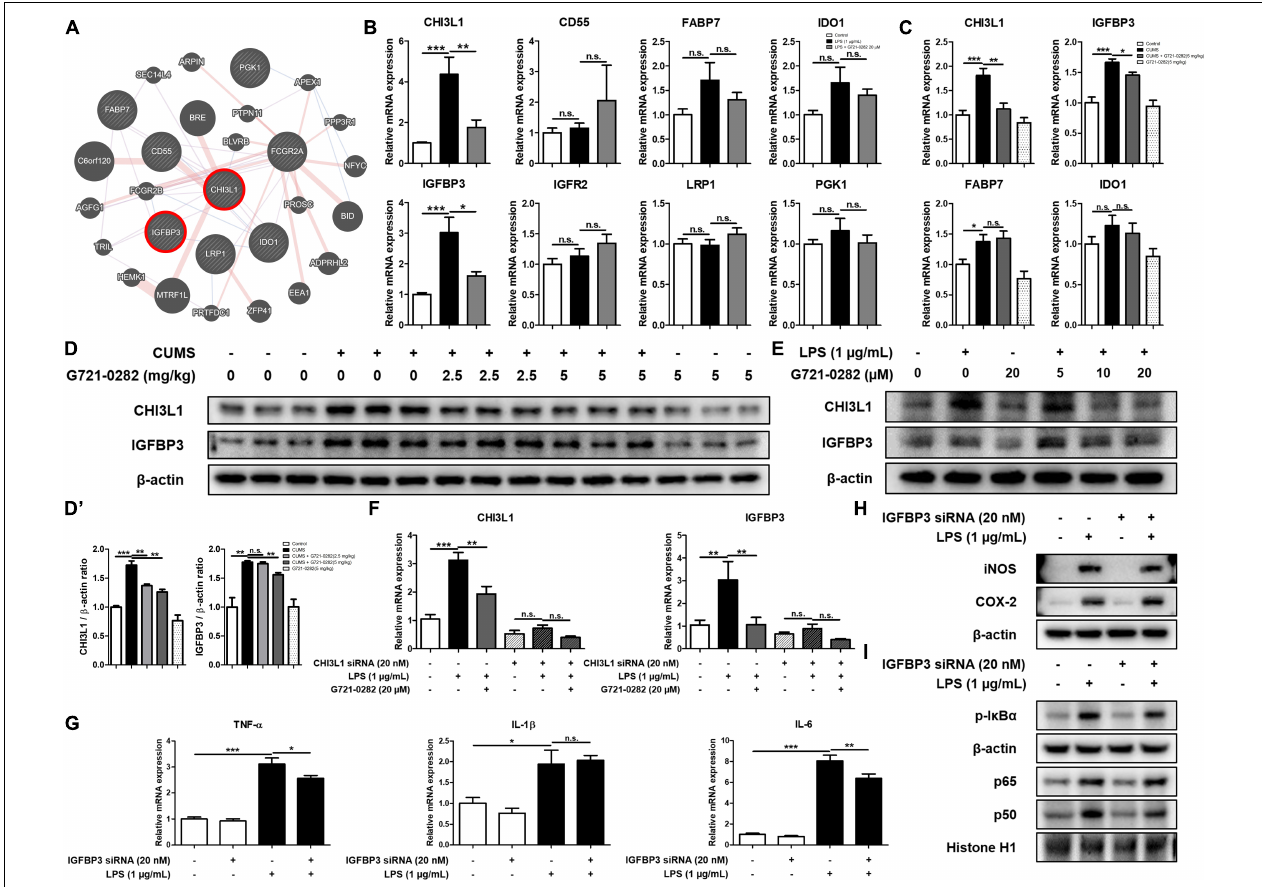
FIGURE 5 | Inhibitory of G721-0282 on IGFBP3-mediated neuroinflammation. Gene network analysis associated with CHI3L1 was carried out using the web-based analysis tool (A) . The mRNA expression level of CHI3L1 related proteins (CD55, FABP7, IDO-1, IGFBP3, IGFR2, LRP1, and PGK1) in BV-2 cells treated with G721-0282 were assessed by qRT-PCR (B) . The mRNA expression level of CHI3L1 related proteins (FABP7, IDO-1, and IGFBP3) in mice brain were assessed by qRT-PCR (C) . The expression of CHI3L1 and IGFBP3 were detected by Western blot in the mice brain (D) , and their expression were normalized to β -actin (D’) . The loading control, β -actin, was reused in Figures 3A,B and (D) , because Figures 3A,B and (D) were obtained from the same amount of the same samples. The expression of CHI3L1 and IGFBP3 were detected by Western blot in BV-2 cells treated with siCHI3L1 and G721-0282 (E) . The mRNA expression level of CHI3L1 and IGFBP3 in BV-2 cells treated with siCHI3L1 and G721-0282 were assessed by qRT-PCR (F) . The mRNA expression level of pro-inflammatory cytokines (TNF- α , IL-1 β , and IL-6) in BV-2 cells treated with siIGFBP3 were assessed by qRT-PCR (G) . The expression of iNOS and COX-2 were detected by Western blot in BV-2 cells treated with siIGFBP3 (H) . Phosphorylation of I κ B, and p50 and p65 (Nuclear) translocation were detected by Western blot in BV-2 cells treated with siIGFBP3 (I) . ∗ , Significantly different between two groups ( p < 0.05). ∗∗ , Significantly different between two groups ( p < 0.01). ∗∗∗ , Significantly different between two groups ( p <